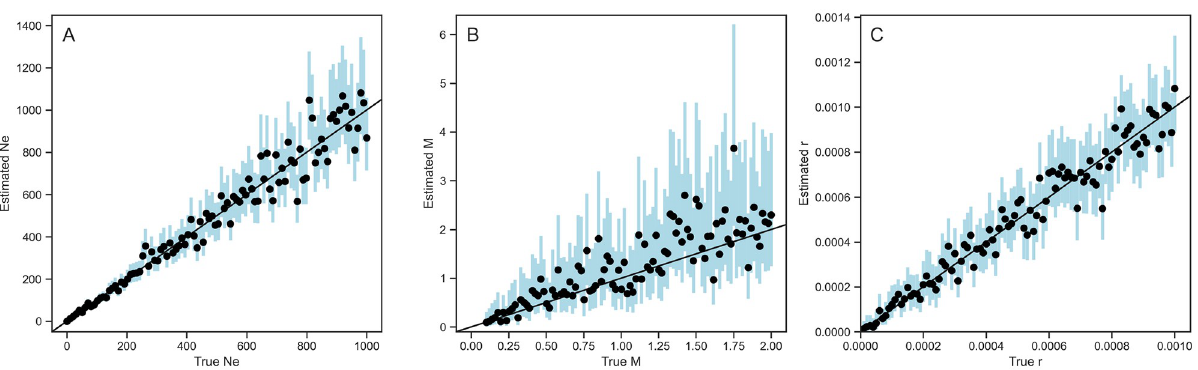
Fig 4. Inference of effective population size N (A), migration rate M (B), and recombination rate r (C) from 100 known ARGs. Migrations rates e are assumed to be equal (symmetric) between two populations. Dots and blue bars represent the median posterior estimates and the 95% credible intervals for each simulation.